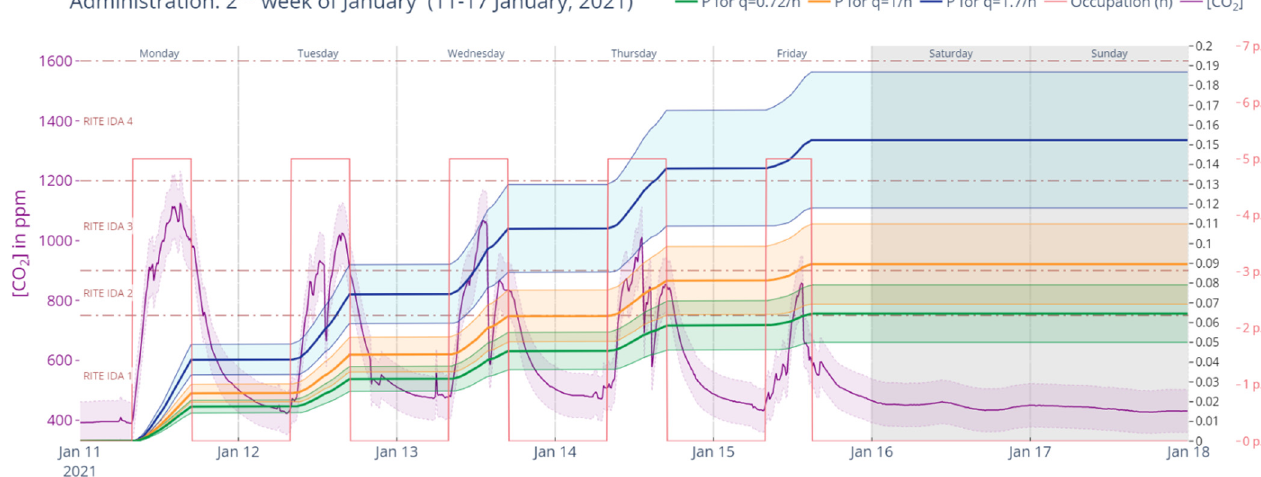
Figure 24. Retrospective analysis of secondary infection risk during the second week of January 2021 (Phase I). Source: authors.